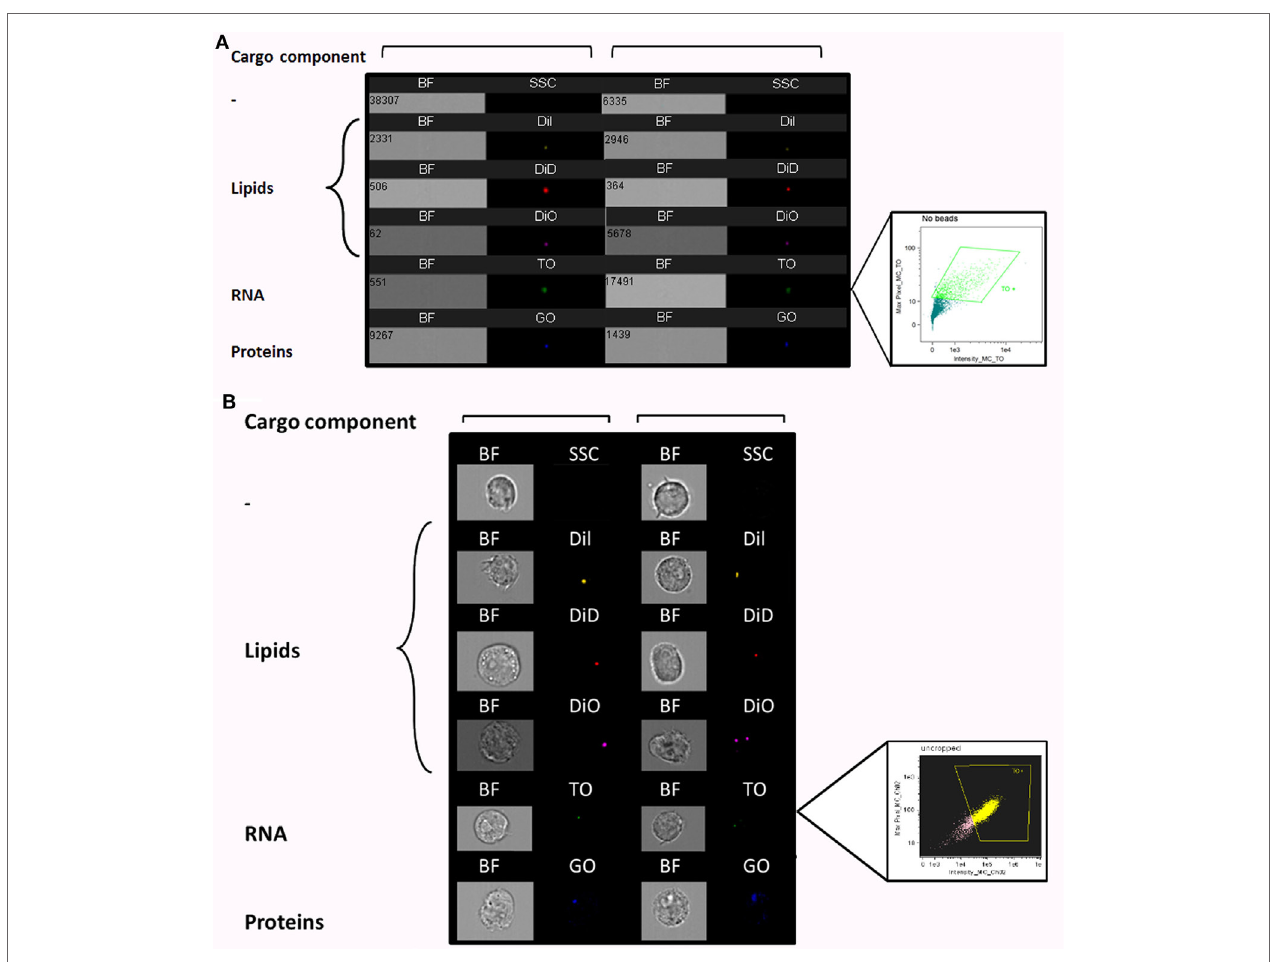
FIgURe 1 | Visualization of Plasmodium falciparum ( Pf )-derived extracellular vesicles (EVs) by imaging flow cytometry (IFC). (A) Visualization of single-stained Pf -derived EVs by IFC. Pf -derived EVs stained with lipid (DiI, DiD, and DiO), RNA [thiazole orange (TO)], or protein (GO) dyes. Insert shows percentage of TO-positive EVs (43%), gated according to unlabeled EVs. Representative results from at least three experiments are shown. Abbreviations: BF, bright field; SSC, side scatter. (B) Internalization (uptake) of Pf- derived EVs into monocytes as visualized by IFC. EVs were stained with lipid (DiI, DiD, and DiO), RNA (TO), or protein (GO) dyes and then 7.5*10 7 dyed EVs were introduced into 1.5*10 6 THP-1 cells for 5 min. The cells were fixated as described in Section “Method” and vesicle uptake was imaged using IFC. EVs are detected as spots inside recipient cells. Insert shows percentage of EV-positive cells (72.5%), gated according to unlabeled EVs. Representative results from at least three experiments are shown. Abbreviations: BF, bright field; SSC, side